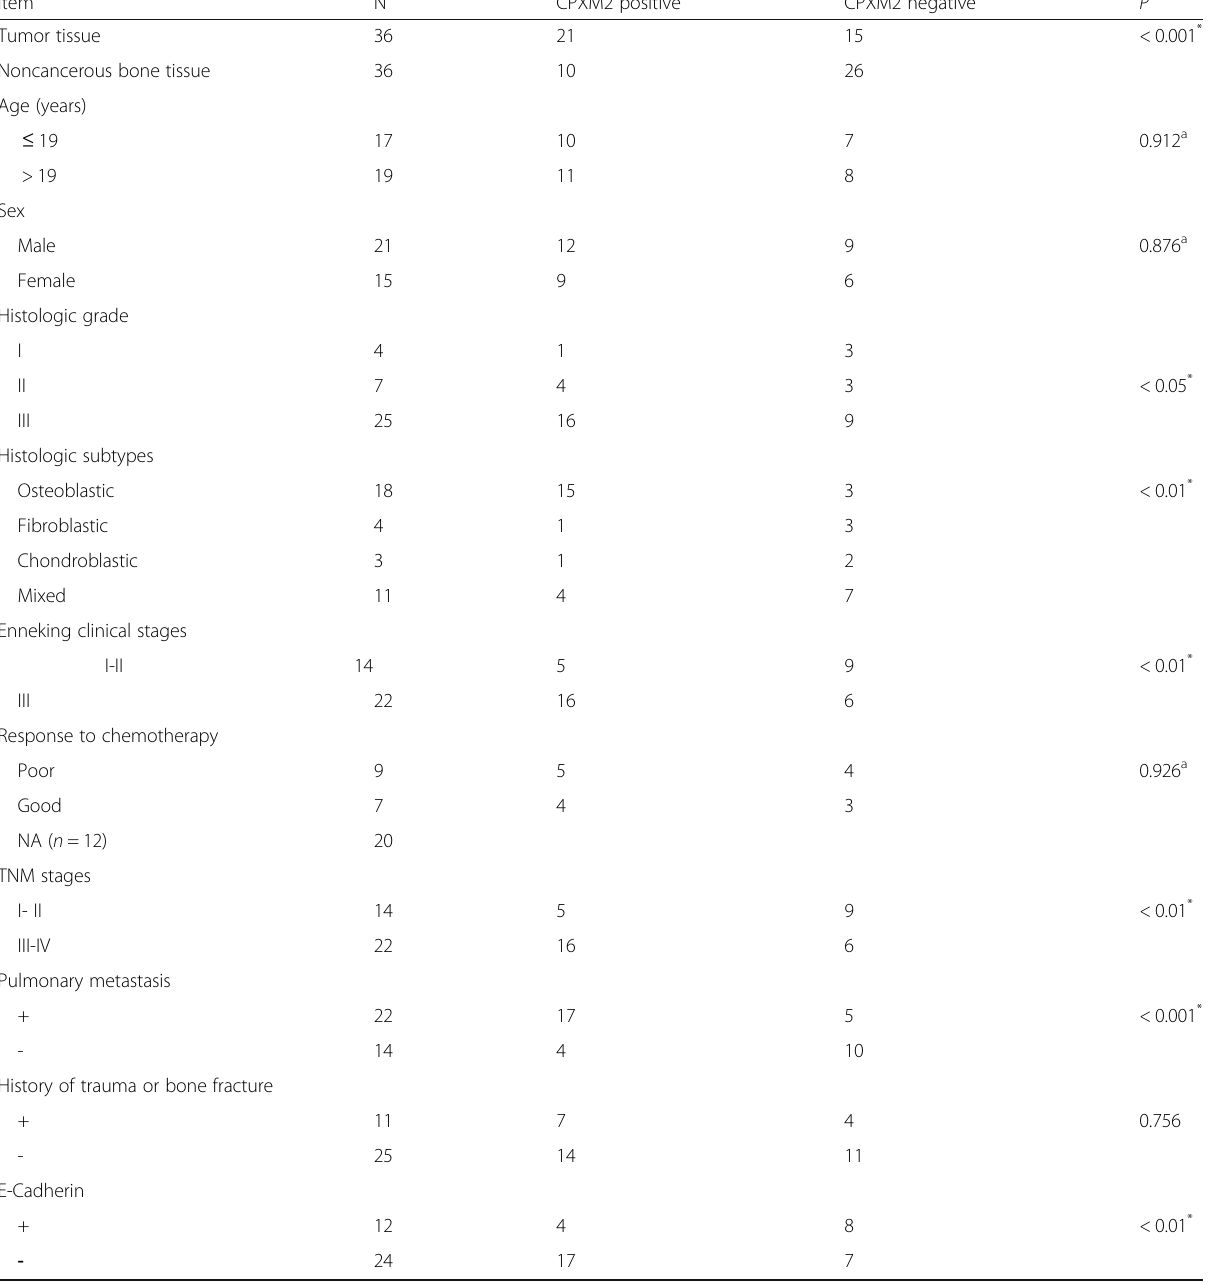
Table 1 Expression of CPXM2 and clinicopathological characteristics in osteosarcoma patients Item N CPXM2 positive CPXM2 negative P Tumor tissue 36 21 15 < 0.001 * 36 10